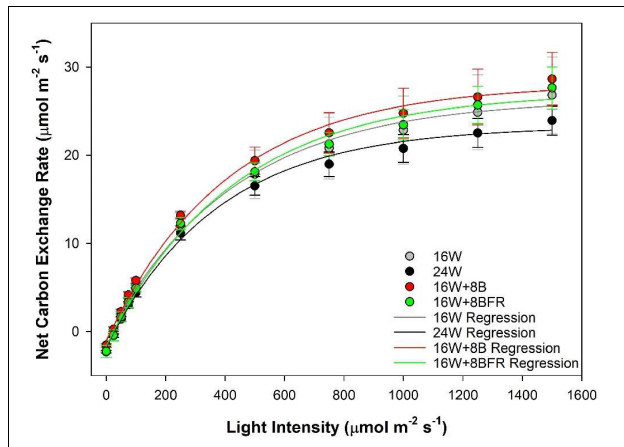
FIGURE 4 | Leaf photosynthetic light response curves of pepper plants grown under the light treatments at 91 DIT as determined using a Li-COR 6400 photosynthesis system with a red/blue standard Li-COR light source. Measurements were made at a CO 2 level of 800 µ L L − 1 , leaf temperature of 22 ◦ C, and relative humidity of 60–70%. Regressions lines were fit to y = y o + a(1-e ( − b ∗ x ) ) for each lighting treatment.